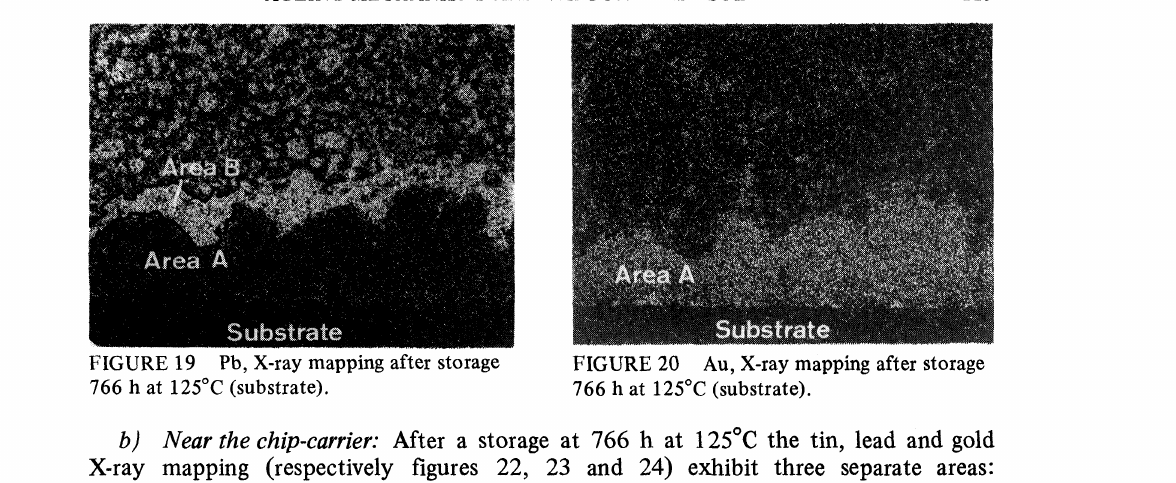
FIGURE 19 Pb, X-ray mapping after storage 766 h at 125C (substrate).